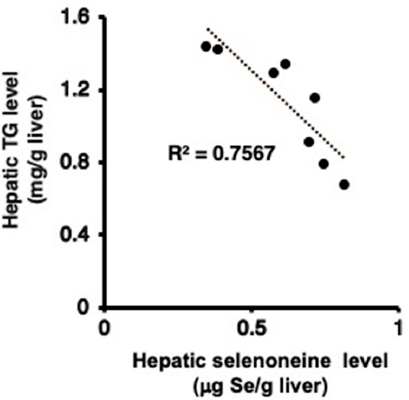
Figure 8. Correlation of hepatic selenoneine concentration with hepatic TG levels. Mice were supplemented with 0.3-mg Se / kg selenoneine for 4